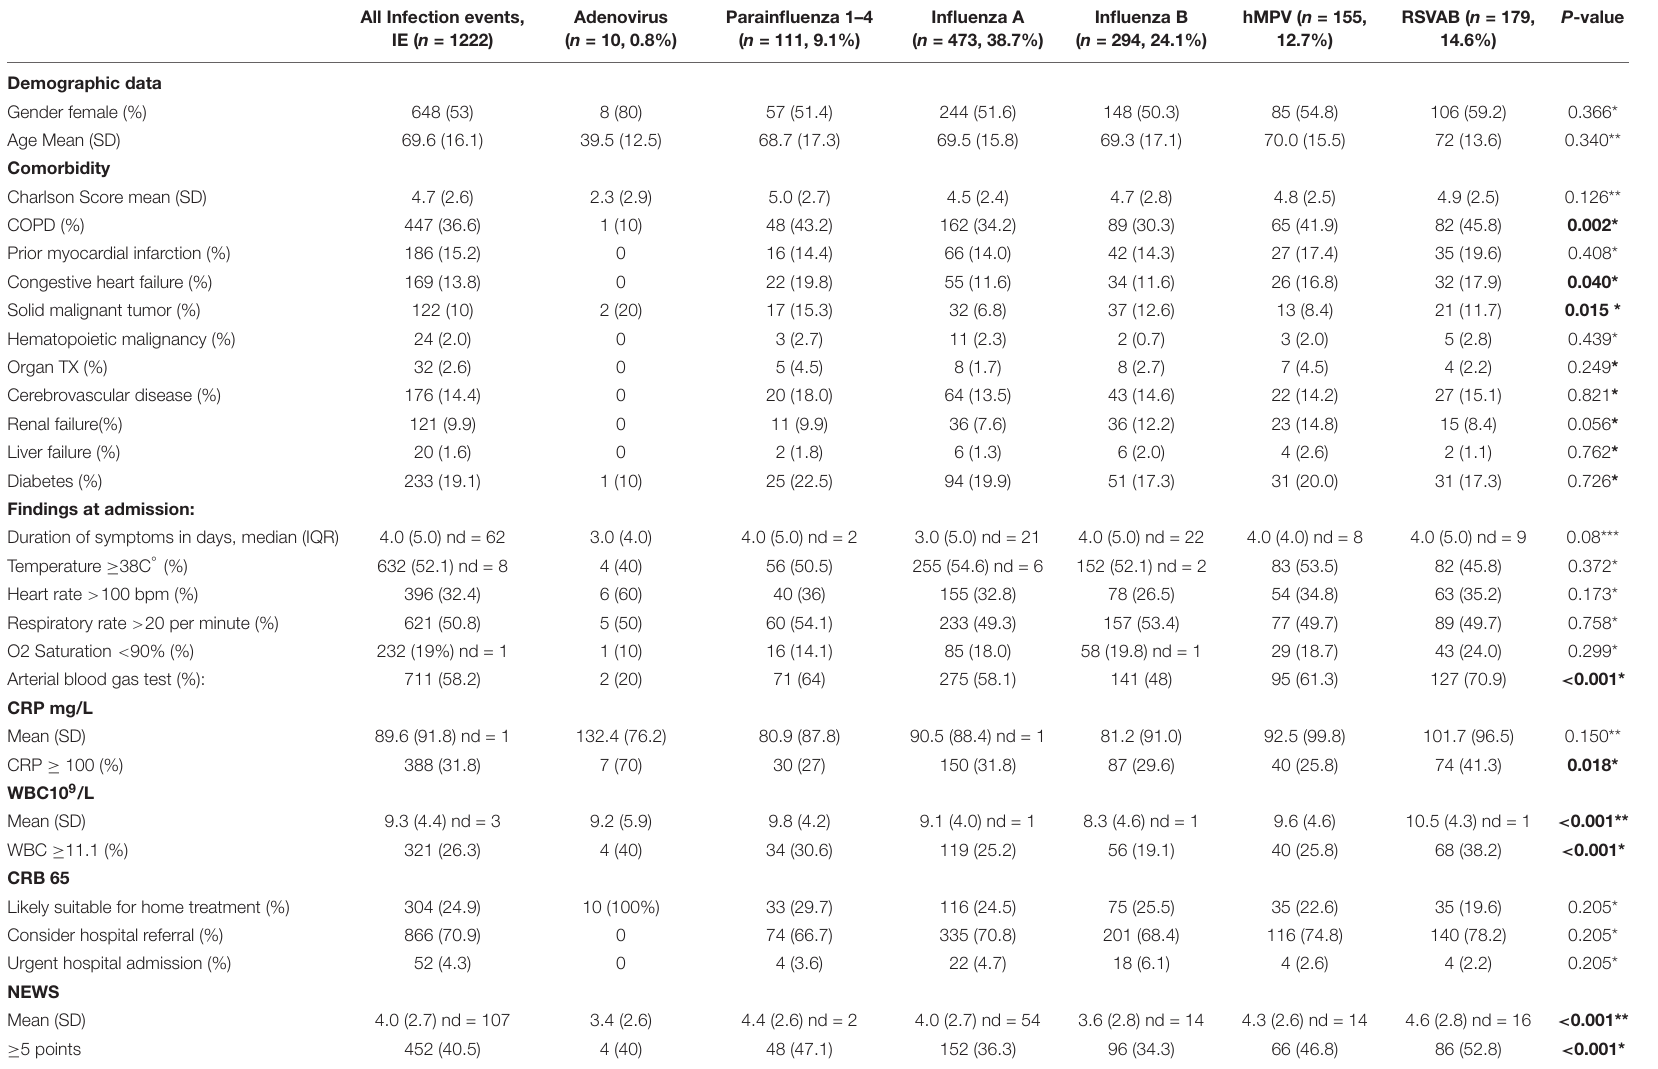
TABLE 1 | Baseline patient characteristics and initial findings in hospitalized adults with confirmed viral RTI, in three consecutive seasons 2015–2018.